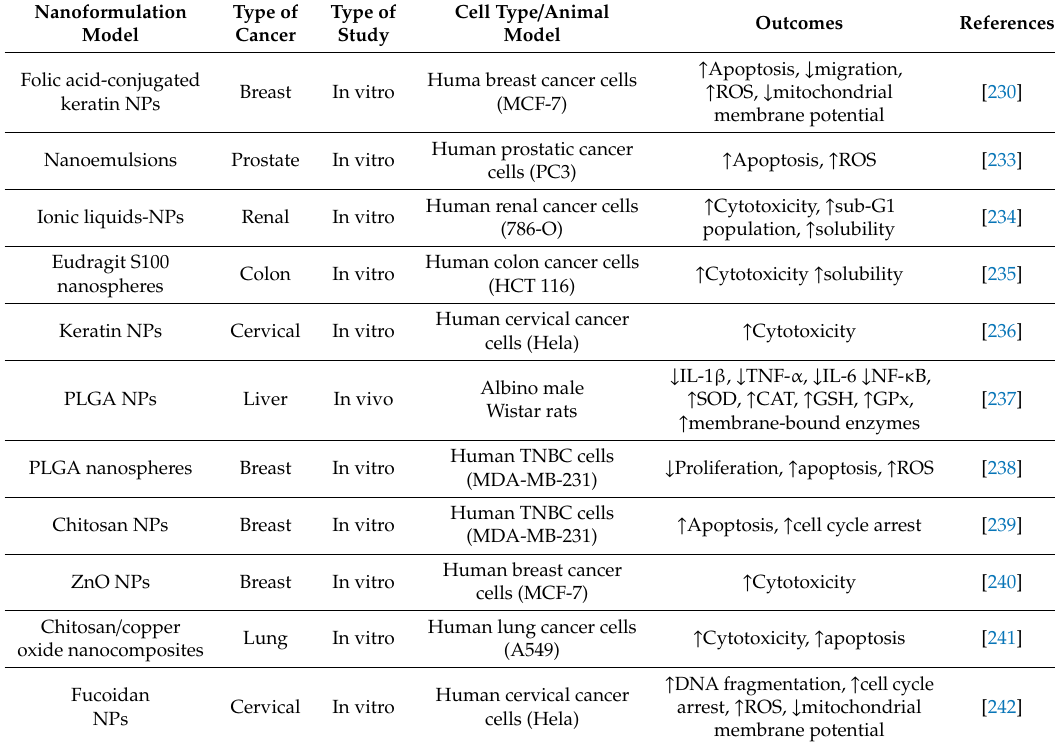
Table 2. Rutin based nanoscale drug delivery systems for counteracting several types of cancer. Nanoformulation